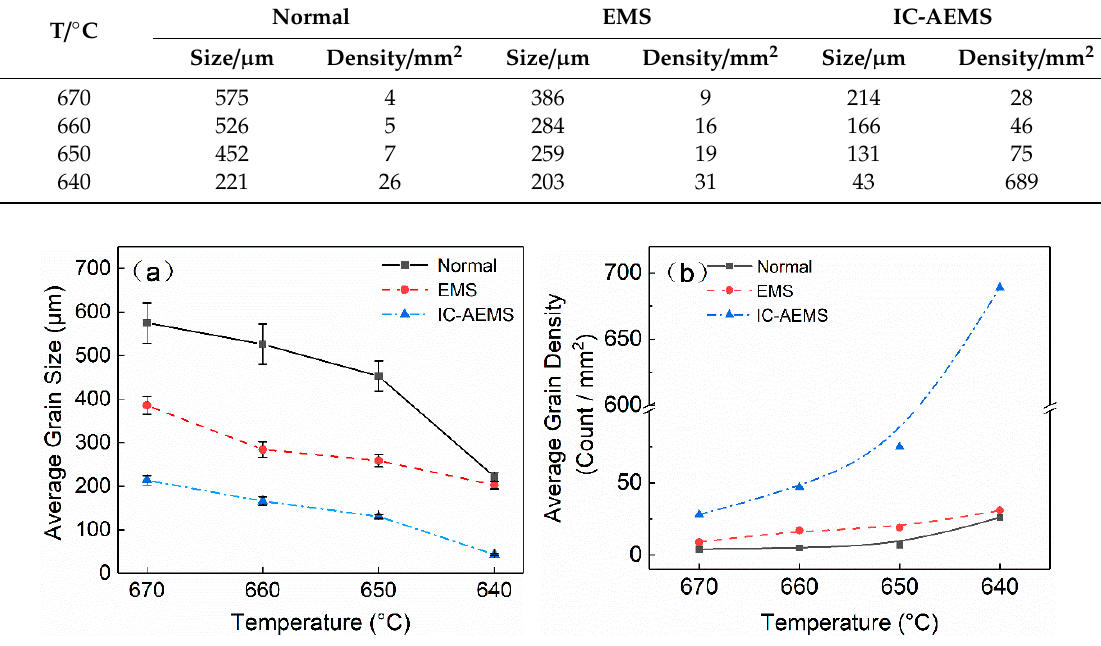
Figure 4. Variation of the ( a ) average grain size and ( b ) average grain density of grains with three different treatments at four selected temperatures.